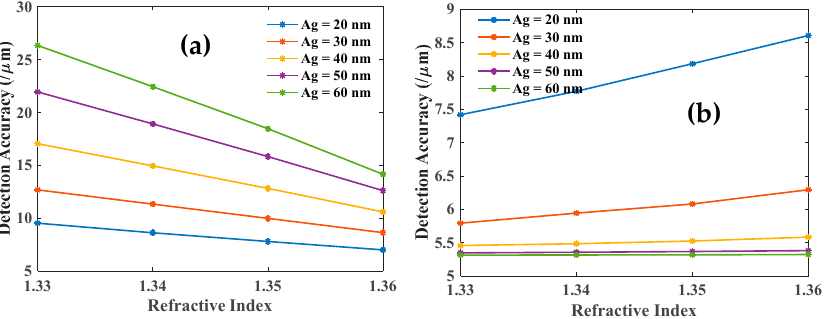
Figure 6. Detection accuracy of the ( a ) LMR and ( b ) SPR dip with the variation of RI of the sensing medium for different thicknesses of the Ag and 80 nm thickness of the ITO layer.